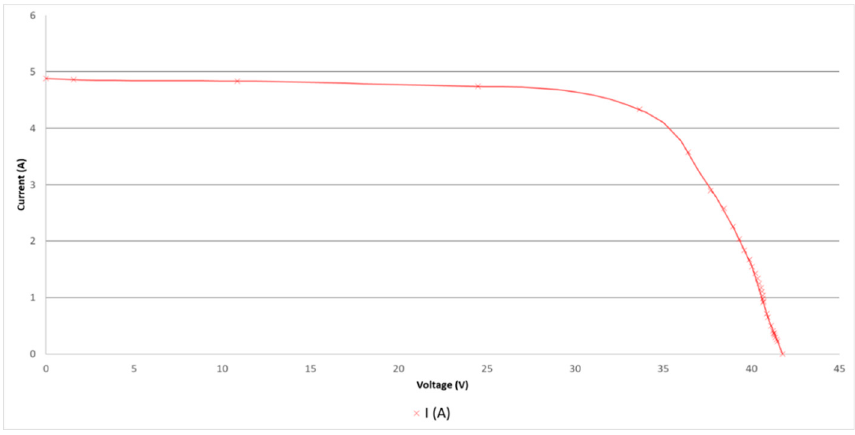
Figure 4. Experimental monocrystalline solar module I–V characteristic curve in condition 1.